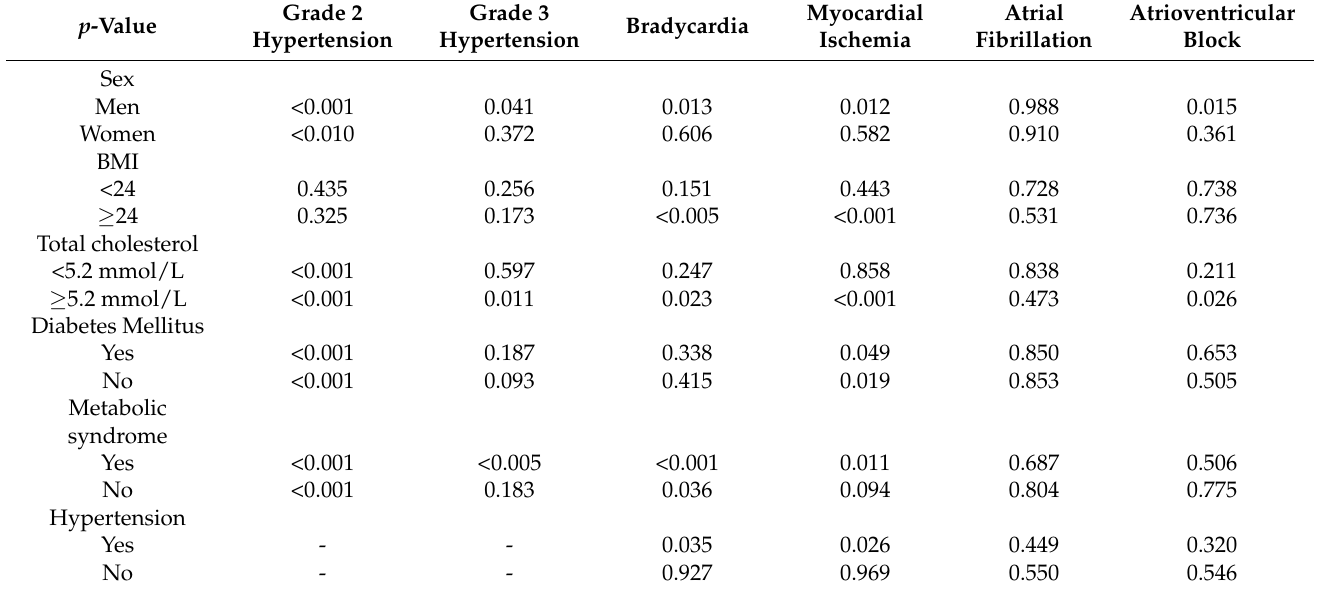
Table 3. The influence for certain factors with exposure to GCF in the development of the CVDs.